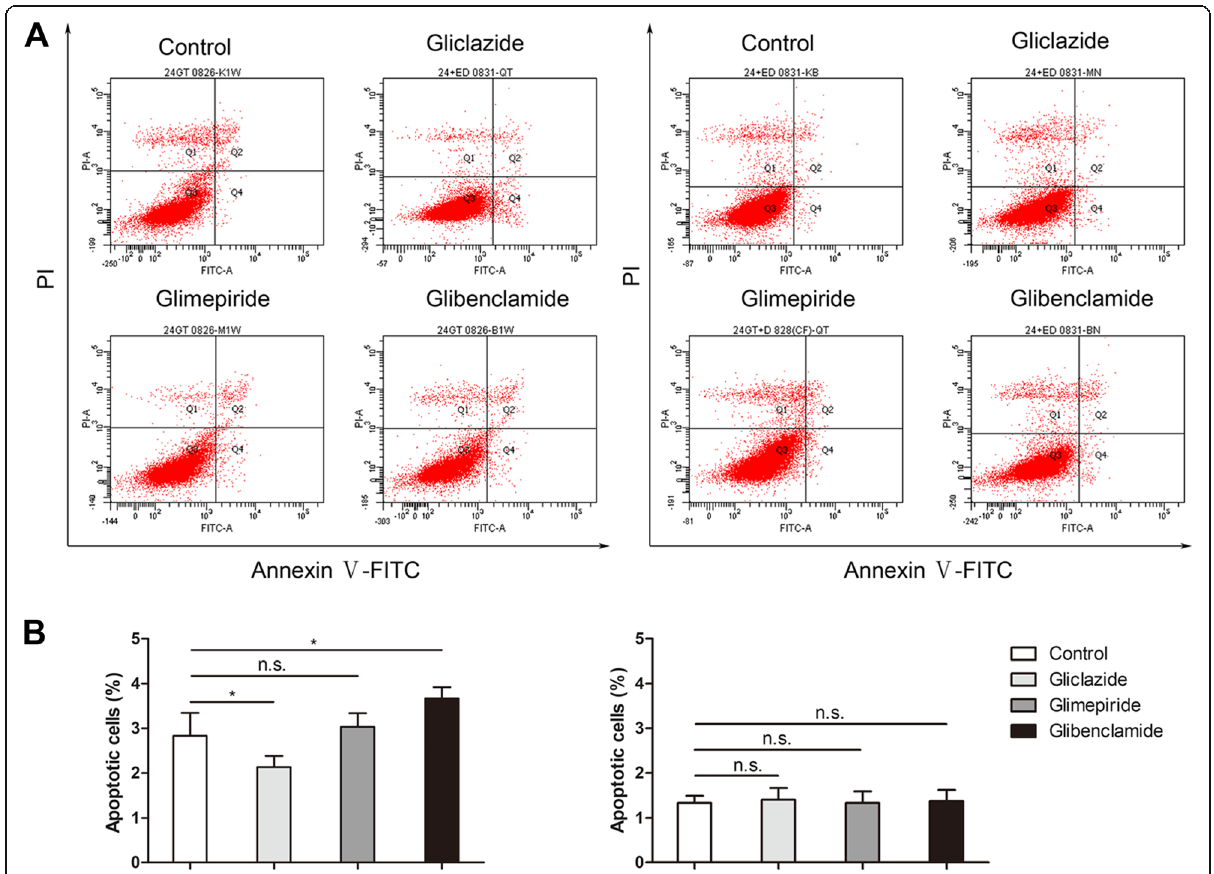
Fig. 1 Effect of diazoxide on SUs-induced apoptosis was determined with Annexin V-FITC/PI staining by flow cytometry. a Flow cytometry results with Annexin V-FITC/PI staining. Cells were treated with SUs (left) and K ATP channel opener (right), DZ, as described above. After culture for 24 h, cells were harvested and then apoptosis was analyzed with an Annexin V-FITC Apoptosis Detection Kit by flow cytometry. Cells were classified as healthy cells (Annexin V − , PI − ), early apoptotic cells (Annexin V + , PI − ), late apoptotic cells (Annexin V + , PI + ), and damaged cells (Annexin V − , PI + ). b The ratio of apoptosis among different experiment groups. Apoptosis ratio was early apoptosis percentage plus late apoptosis percentage. The date were presented as the mean ± SD. Columns, mean of three independent experiments; bars, SD; * p < 0.05 , ** p < 0.01 , n.s. not